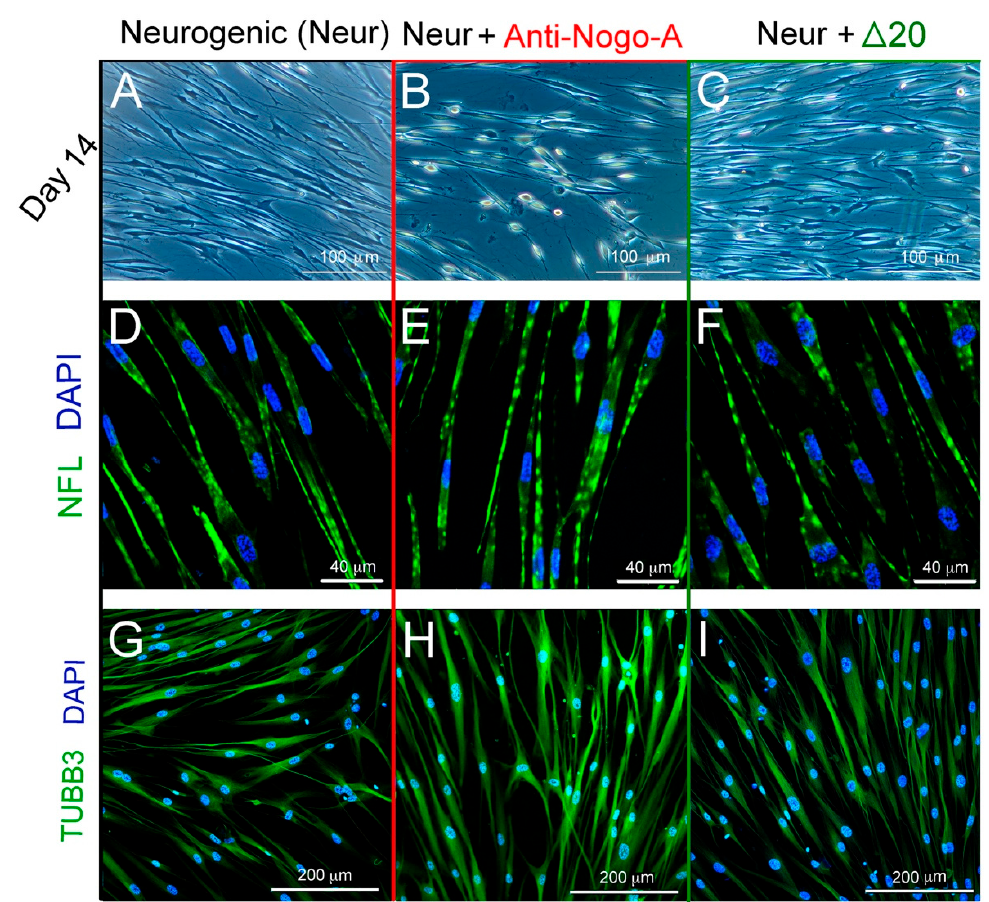
Figure 8. Effects of the Nogo-A protein and anti-Nogo-A antibody on hDPSCs neuronal differentiation. ( A – C ) Morphological changes of hDPSCs cultured in neurogenic induction medium (Neur) alone ( A ), in neurogenic medium supplemented with the anti-Nogo-A-antibody ( B ), and in neurogenic medium supplemented with the Nogo-A ∆ 20 protein ( C ) for 14 days. ( D – F ) Neurofilament-L (NFL) immunofluorescent staining (green color) in hDPSCs cultured for 7 days in neurogenic medium alone ( D ), in neurogenic medium supplemented with the anti-Nogo-A-antibody ( E ), and in neurogenic medium supplemented with the Nogo-A ∆ 20 protein ( F ). DAPI (blue color) marks cell nuclei. ( G – I ) Tubulin Beta-III (TUBB3) immunofluorescent staining (green color) in hDPSCs cultured for 7 days in neurogenic medium alone ( G ), in neurogenic medium supplemented with the anti-Nogo-A-antibody ( H ), and in neurogenic medium supplemented with the Nogo-A ∆ 20 protein ( I ). DAPI in blue color. These changes were confirmed by RT-qPCR analysis for Doublecortin ( DCX )